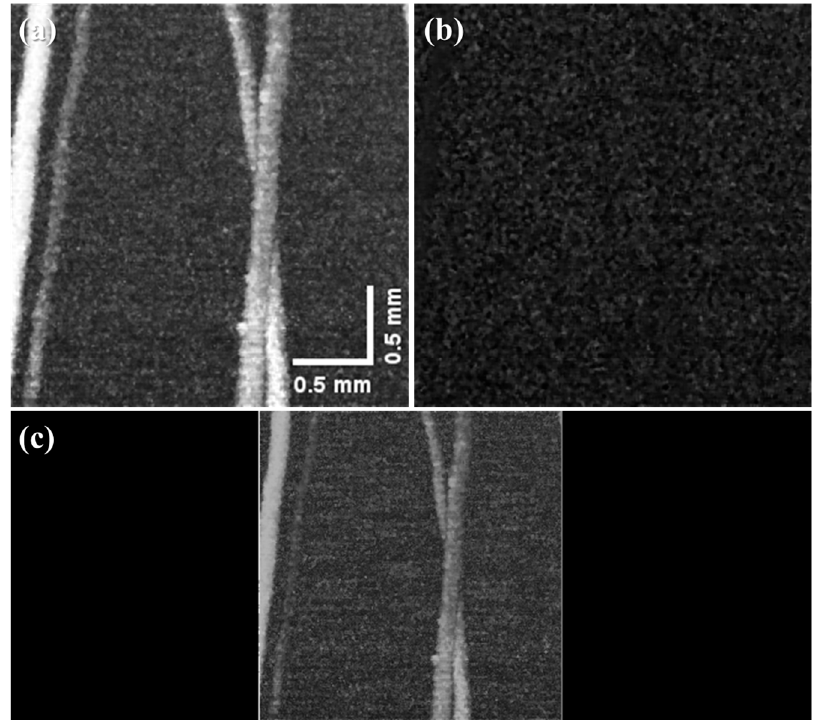
Figure 9. Reconstructed hair PA image results: ( a ) MIP image result; ( b ) PA image result by depth; ( c ) 3D rotation view of the hair PA image result; ( b , c ) are video clips (ref. attachment